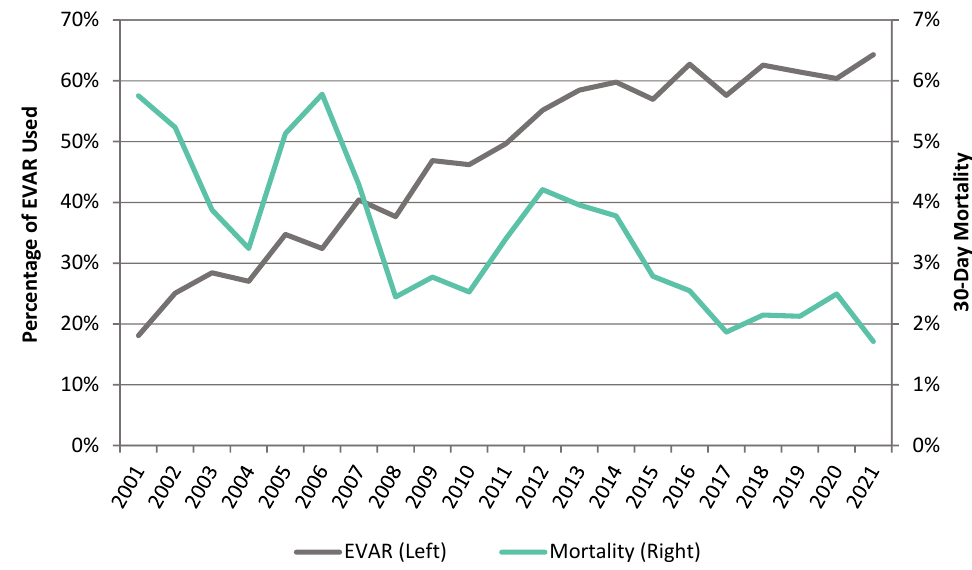
Figure 6. Intact AAA 30-day post-operative mortality and proportion of EVAR usage. For patients undergoing ruptured AAA repair, there was no change in outcomes with a mean 30-day mortality of 31.6%. There was an increase in EVAR usage for ruptured AAA from 0.8% in 2001 to 28.8% in 2021. (Figure 7). The 30-day mortality for patients who had an EVAR for a ruptured AAA (rEVAR) decreased from 34.1% to 28.8%.